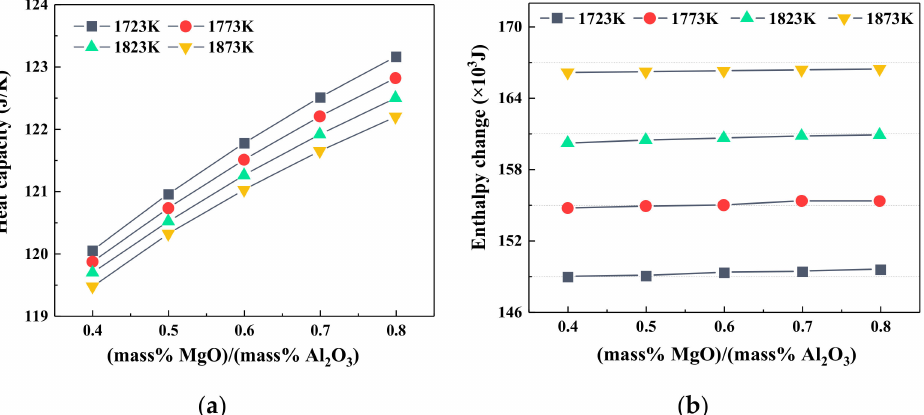
Figure 7. The heat capacity and enthalpy change of slag with different MgO/Al 2 O 3 ratios; ( a ) heat capacity; ( b ) enthalpy change.